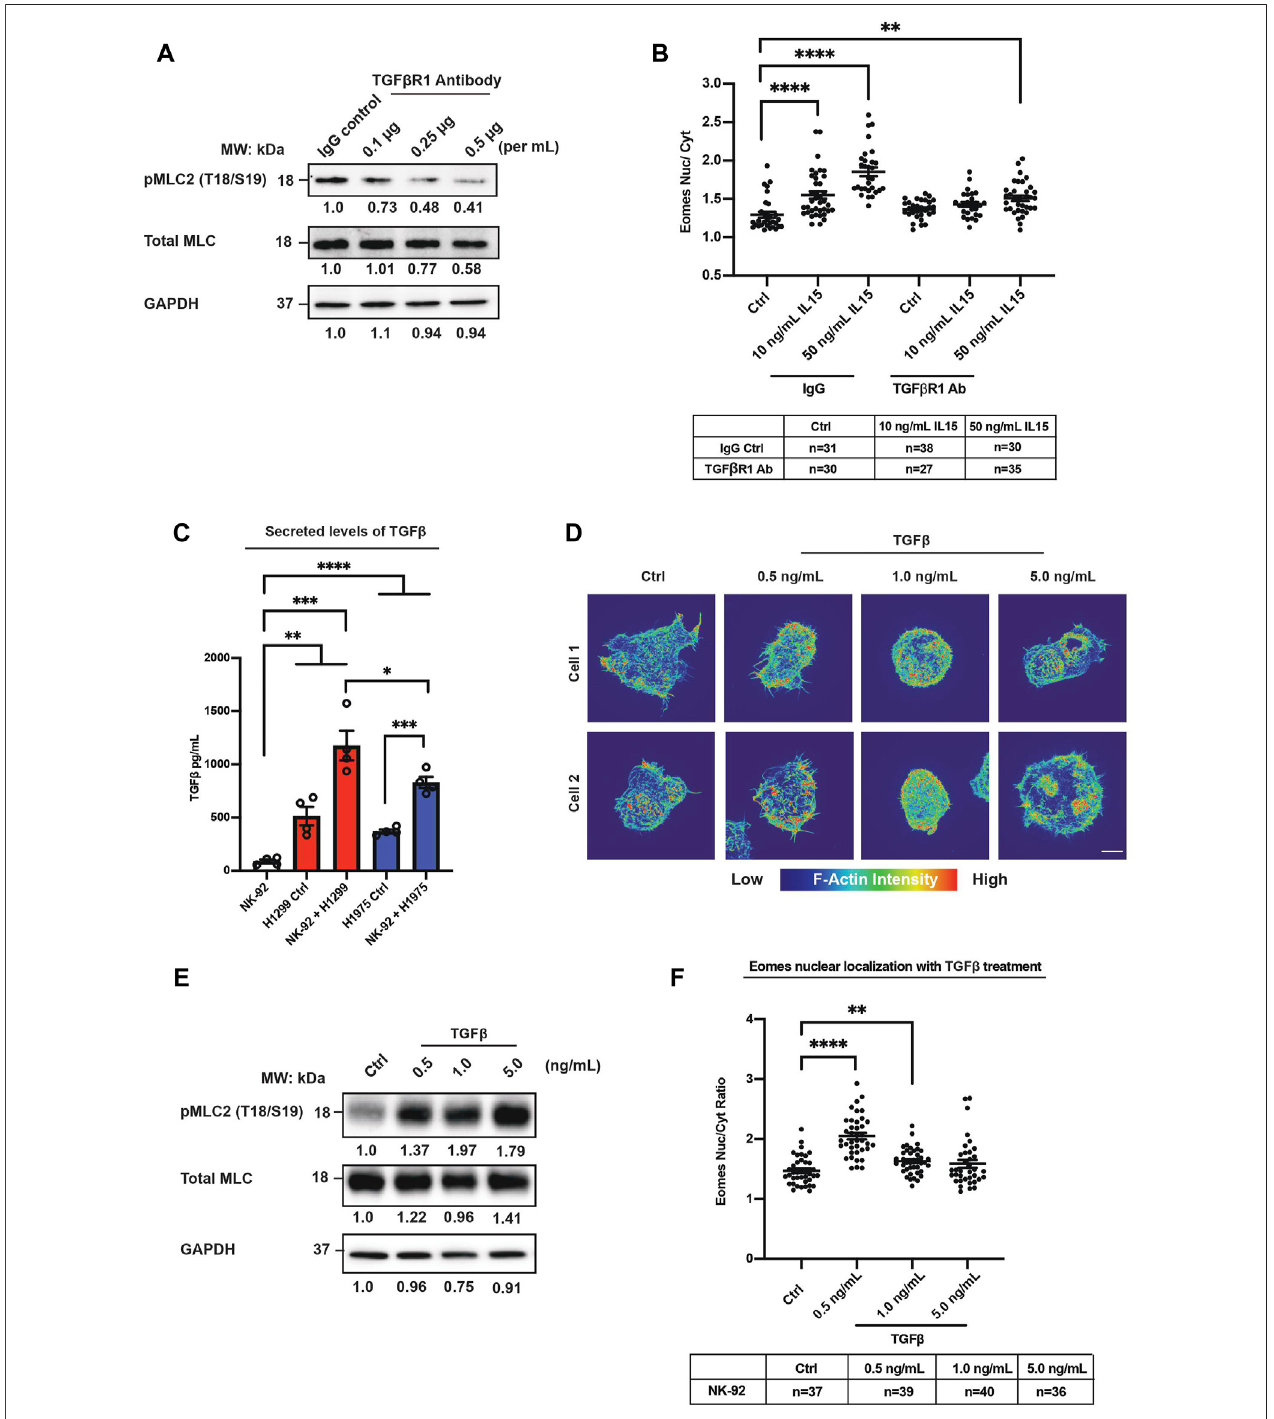
FIGURE 5 | TGF β -induced myosin light chain phosphorylation is associated with Eomes nuclear localization . (A) Western blot with densitometric quanti fi cation (numerically represented below each band) shows that TGF β 1R antibody blocking reduced pMLC2 (Thr18/Ser19) expression in a dose-dependent manner, n = 3. (B) IL15 induced dose-dependent increase in Eomes nuclear localization in NK-92 cells, whereas TGF β R1 antibody blocking (compared to control IgG) suppressed IL15- induced nuclear localization of Eomes in NK-92 cells. n is represented in the table below the graph. One way ANOVA was used to compare the means of each group. (C) ELISA quanti fi cation of TGF β in supernatants from individual cultures and cocultures showed higher TGF β levels in the presence of H1299 cells, n = 4. Unpaired students t -test was used to compare between groups. (D) SIM super-resolution images show enhancement of F-actin concentration in NK-92 cells that were pre-treated with TGF β . The scale below represents the color coding for actin intensity. All samples were stained with a master mix of phalloidin, speci fi c for F-actin, and